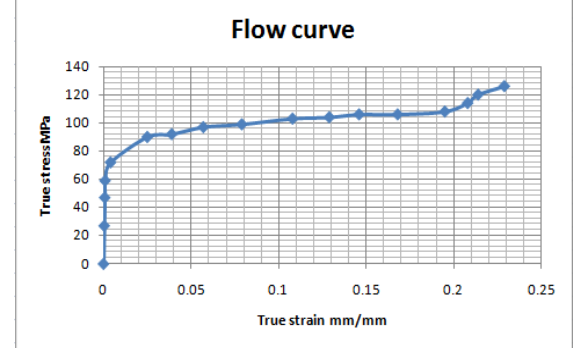
Fig. 3. Specimen with grid, A. before tensile test, B. after tensile test